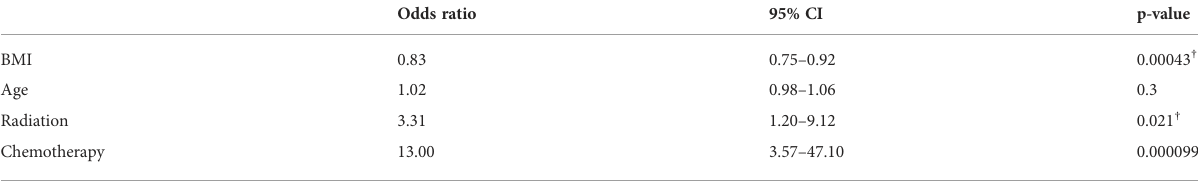
TABLE 6 Comparison of patients with recurrent and nonrecurrent cancer following cancer